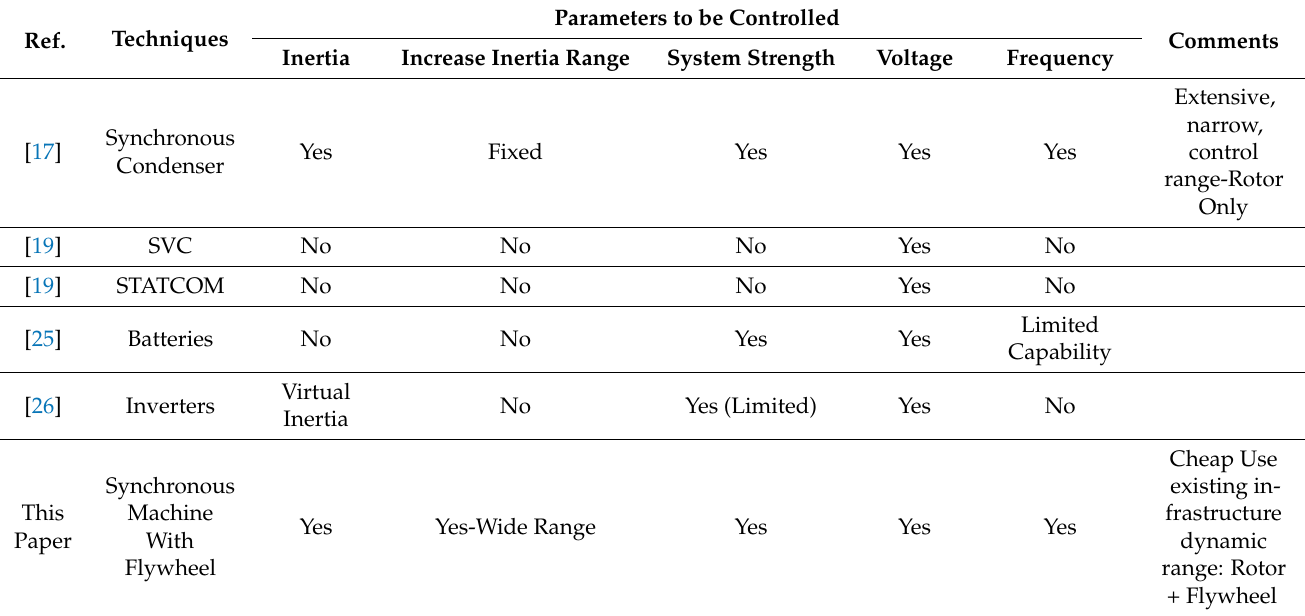
Table 1. Main features comparison for existing techniques available in the literature and this